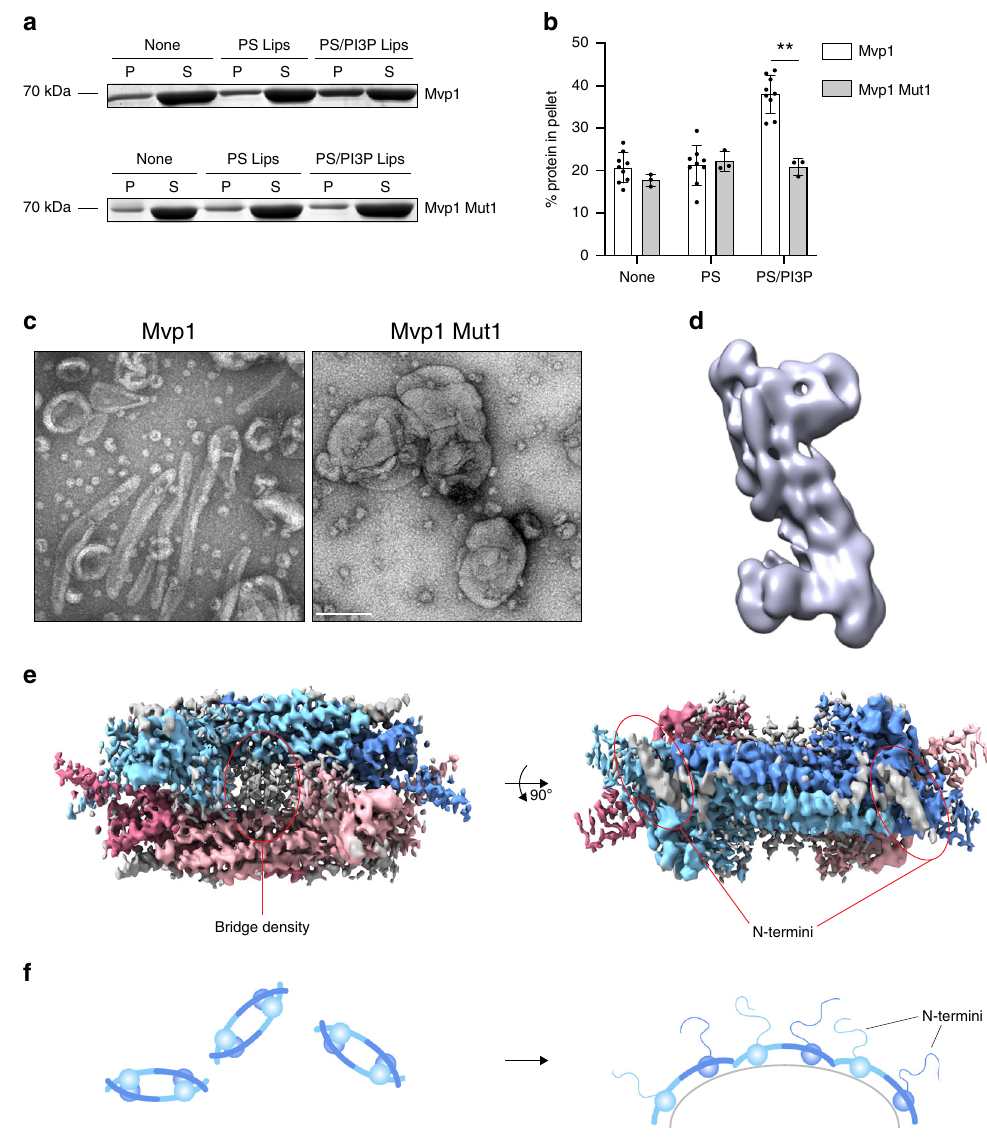
Fig. 4 Mvp1 Mut1 is defective in membrane binding and remodeling in vitro. a Comparison of liposome binding by Mvp1 and Mvp1 Mut1. Protein (1.2 μ M) was incubated without or with DOPS (PS) or DOPS + 5% PI3P (PS/PI3P) liposomes for 30 min at 21 °C prior to sedimentation. A representative result is shown. P pellet, S supernatant. Positions of molecular weight markers are shown to the left of the gels. b Quanti fi cation of the results presented in a . Individual data points and mean ± s.d. are shown. n = 9 for Mvp1 and 3 for Mvp1 Mut1. A 3 × 2 factorial ANOVA was conducted to determine the effects of the mutation (Mvp1 or Mvp1 Mut1) or the absence or presence of liposomes on the % sedimentation of protein. There was a signi fi cant interaction term ( P = 0.0001) and both effects of liposome and Mvp1 or Mvp1 Mut1 were also signi fi cant ( P < 0.0001 and P = 0.0002). A selected pair of values signi fi cant (Tukey HSD) at the 1% level is shown (**). Please note that the same data set for Mvp1 was used to compare with Mvp1 Mut1 here as was used to compare the different Mvp1 puri fi cation protocols presented in Supplementary Fig. 2b. For a and b , source data are provided as a Source Data fi le. c Mvp1 Mut1 is unable to tubulate PS liposomes containing 5% PI3P. Representative micrographs of negative-stained liposomes incubated either with Mvp1 or with Mvp1 Mut1 are shown. Scale bar — 200 nm. d Mvp1 Mut1 is dimeric. Representative cryo-EM 3d class average of Mvp1 Mut1, with an approximate resolution of 8 Å. e Unassigned density. The D2-symmetrized, sharpened map, at contour level 4 σ , is colored according to distance from the atomic model of the Mvp1 tetramer: color is assigned if the density is within 3 Å of the atomic model. The unassigned density is therefore shown in gray. f Model of membrane remodeling by